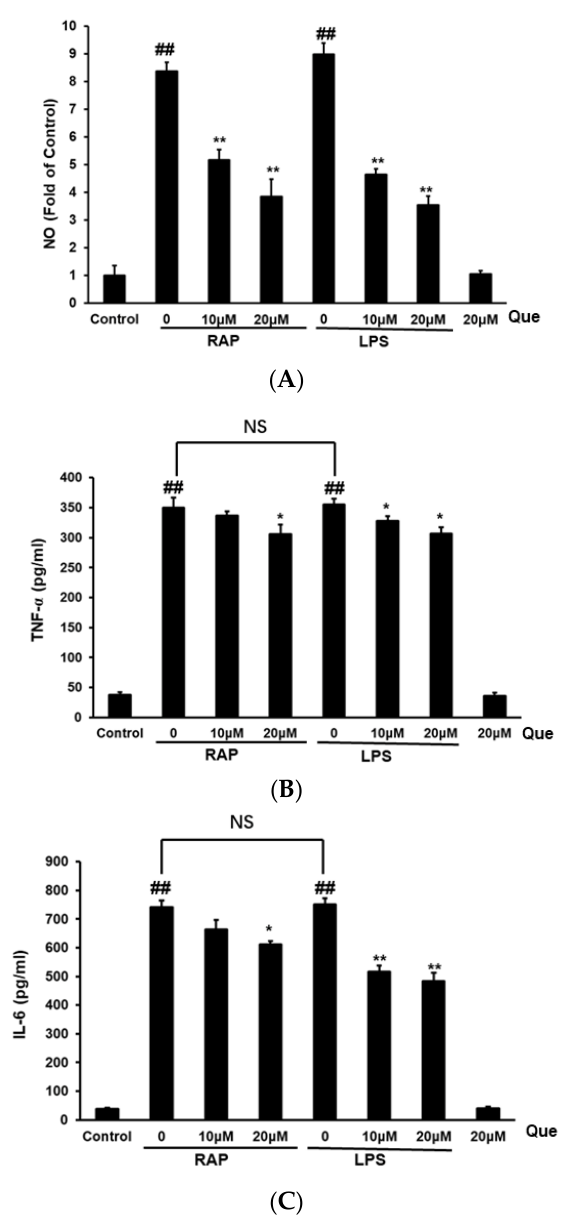
Figure 2. Effects of quercetin on nitric oxide (NO) ( A ), TNF- α ( B ) and IL-6 ( C ) production in RAP- and LPS-induced RAW264.7 macrophages. RAW264.7 cells were incubated with quercetin (10, 20 μ M) and then treated with RAP (100 μ g/mL) or LPS (100 ng/mL) for 24 h. Data from the experiments are expressed as mean ± SD (## p < 0.01 compared with control group; * p < 0.05, ** p < 0.01 compared with the RAP or LPS group).